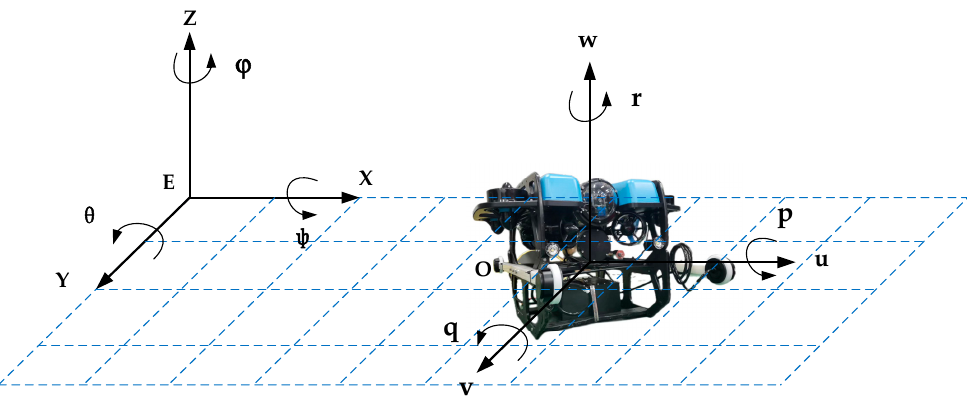
Figure 1. Six-degree-of-freedom model of UUV.